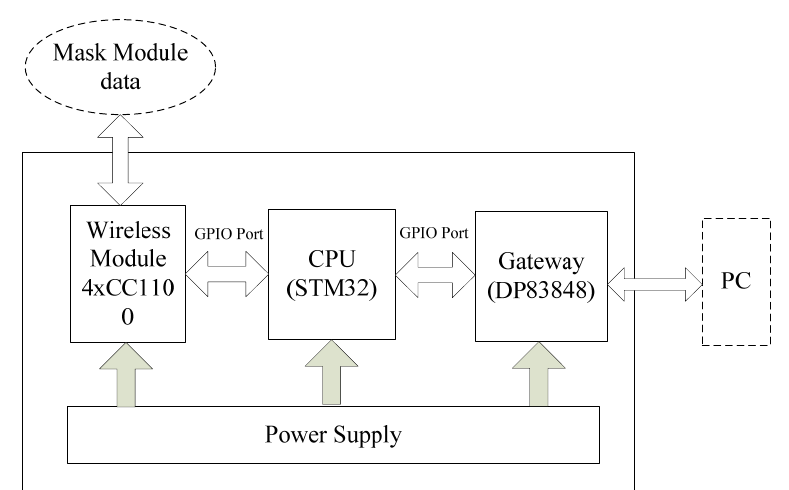
Figure 5 . The wireless gateway